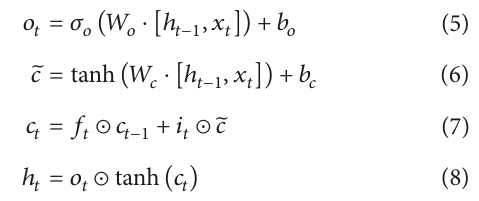
ℎ 푐 𝑡 and 𝑡 represent the